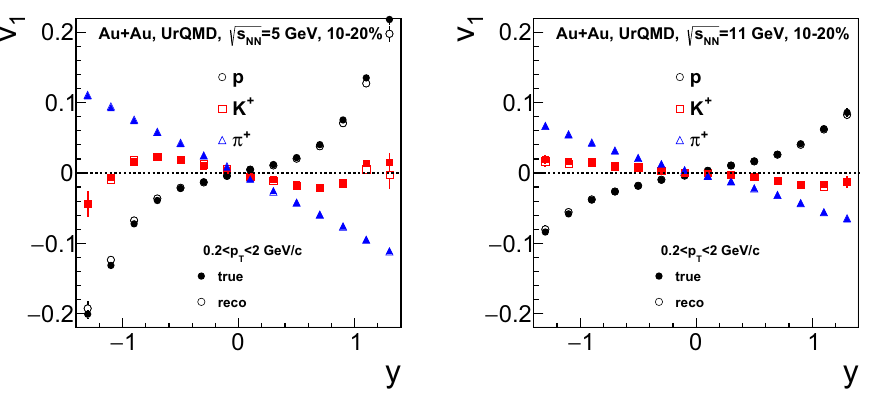
√ s = 5 (left) and 11 GeV (right). The NN